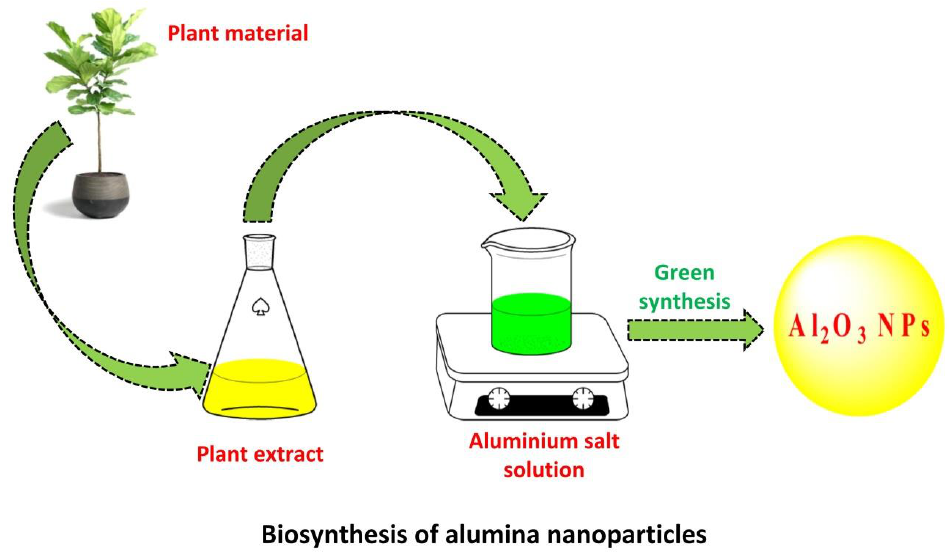
Fig. 3. Schematic representation of green synthesis of Al Figure 3. Schematic representation of green synthesis of Al 2 O 3 NPs